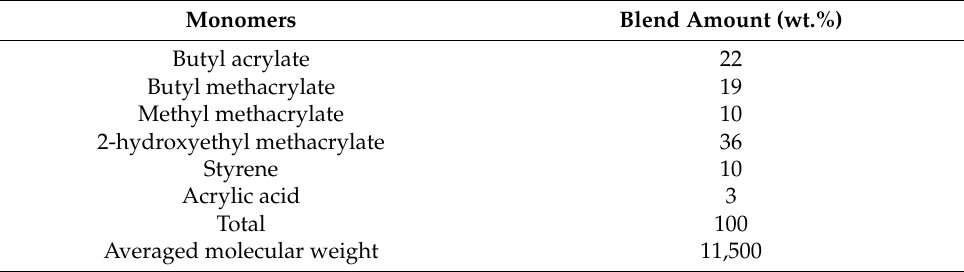
Table 2. Monomer composition and averaged molecular weight of acrylic